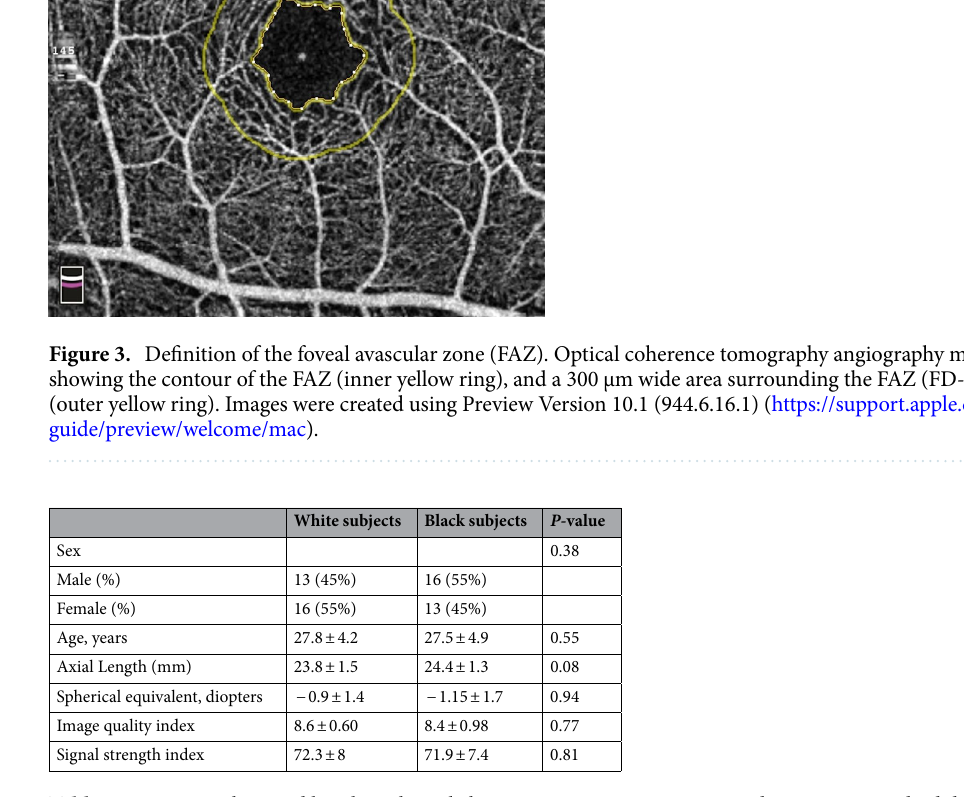
Table 1. Demographics and baseline clinical characteristics. Data are presented as mean ± standard deviation. For baseline data, P values were calculated using Pearson’s chi-squared test for categorical variables and the Wilcoxon rank-sum test for continuous